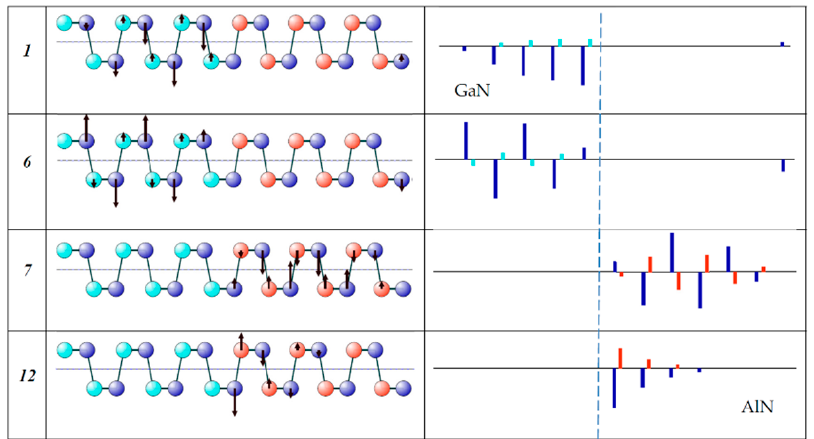
Figure 7. Eigenvectors of the E (TO) modes ( x -displacement of atoms) corresponding to the edges of the E (TO)-GaN (1,6) and E (TO)-AlN (7, 12) lines. Atomic displacements for the high (a,c) and low (b,d) intensity modes E (GaN) (left column) and E (AlN) (right column) in (GaN) 6 /(AlN) 6